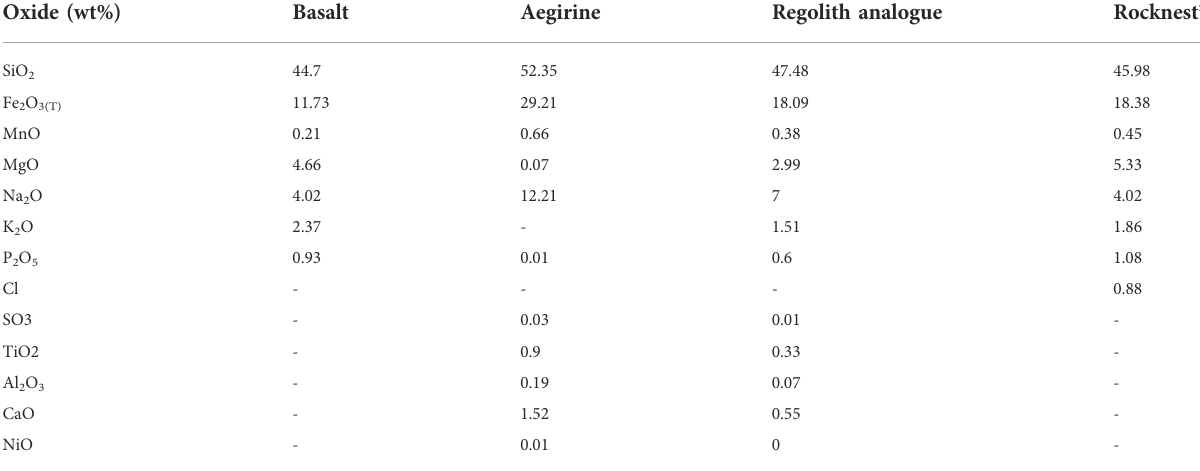
TABLE 1 Major element composition of the basalt, aegirine and regolith simulant in comparison to Rocknest composition.